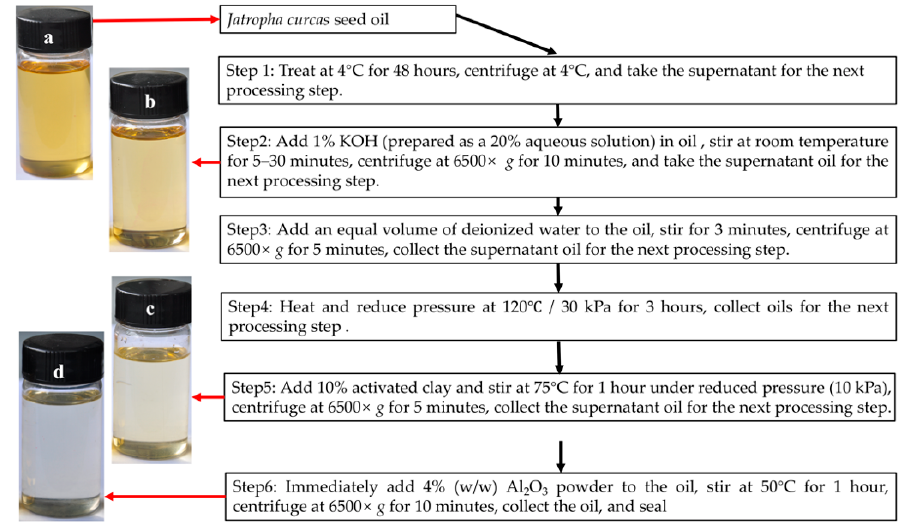
Figure 1. The six-step process of de-acidifying JNIO (show the specific process). a: crude Jatropha curcas oil (CJCO); b: oil following alkaline refinement; c: oil following activated clay treatment; d: Jatropha curcas natural vegetable insulating oil (JNIO). Red arrow indicates the corresponding processed oil; black arrow indicates the processing progress. Steps one to six of this procedure are: cold treatment, alkaline refining, water wash, high-temperature decompression treatment, clay treatment, Al 2 O 3 treatment.